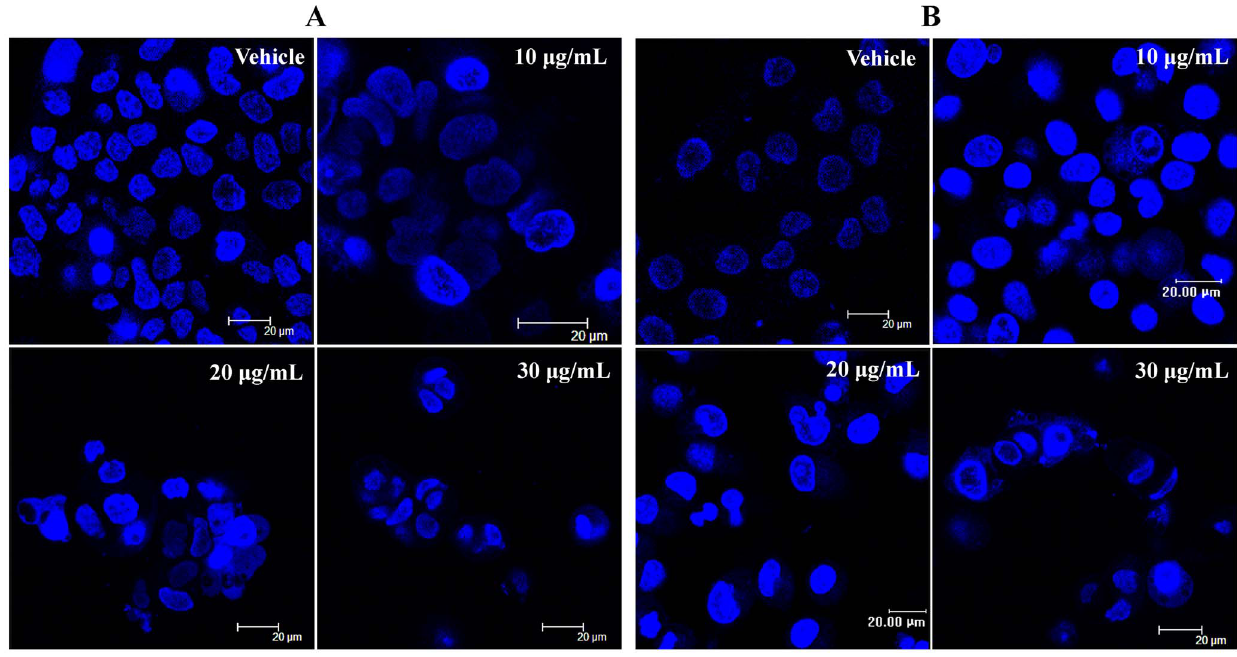
Figure 2. Spiclomazine induces morphological alterations. After cells were treated with various concentrations of spiclomazine for 48 h, cells were stained with Hoechst 33342 and examined using confocal laser scanning microscopy.